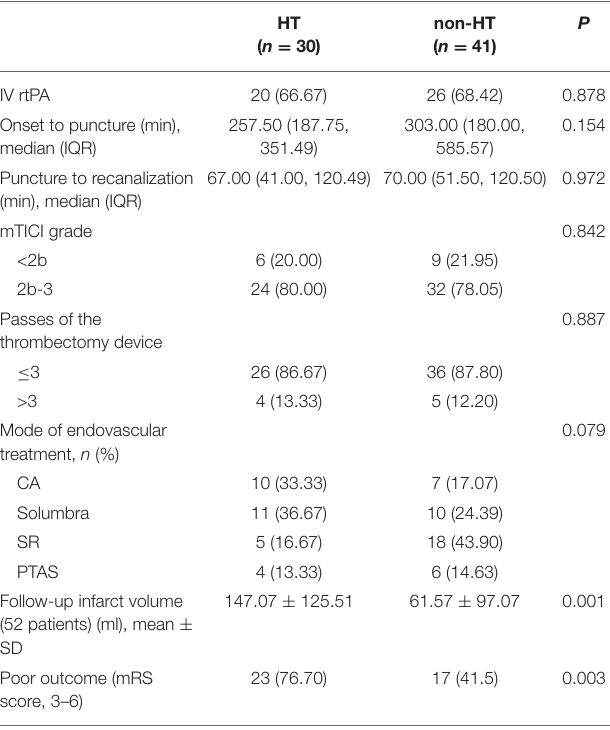
TABLE 2 | Data of endovascular